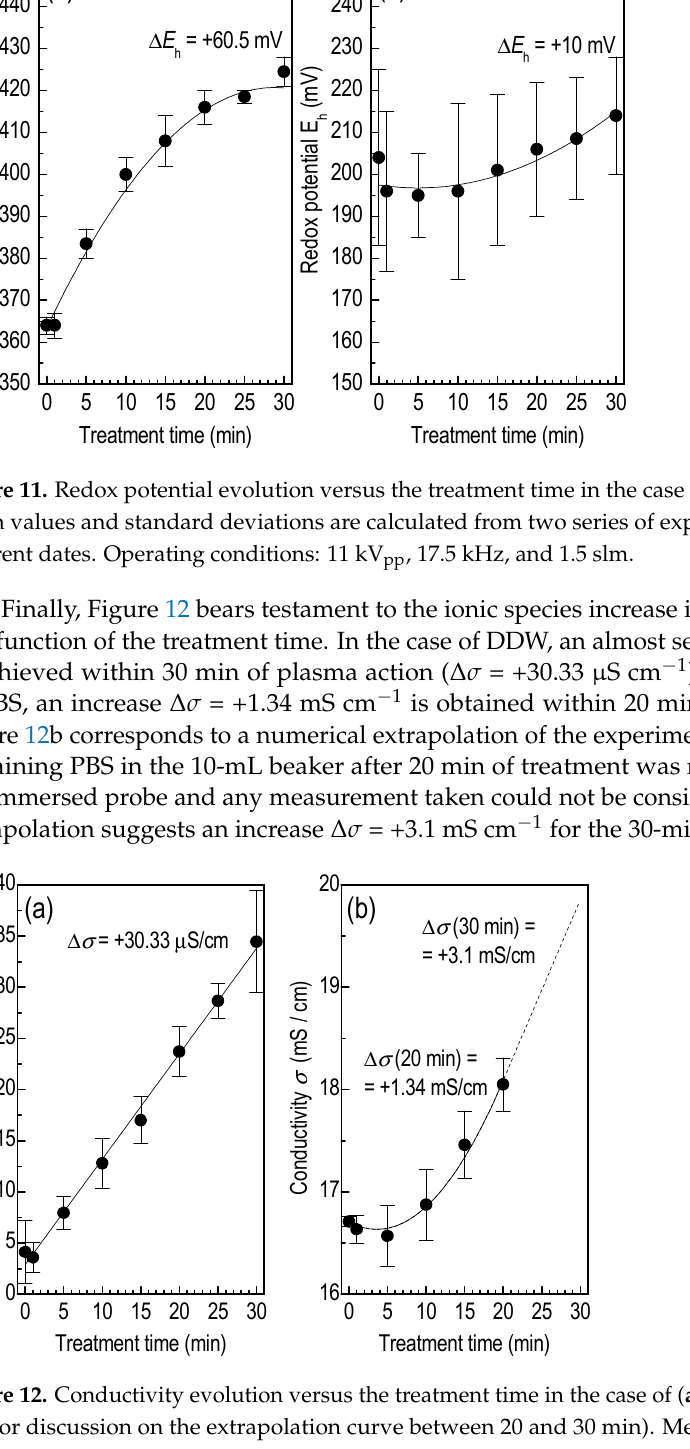
and standard deviations are calculated from two series of experiments carried out on different dates.